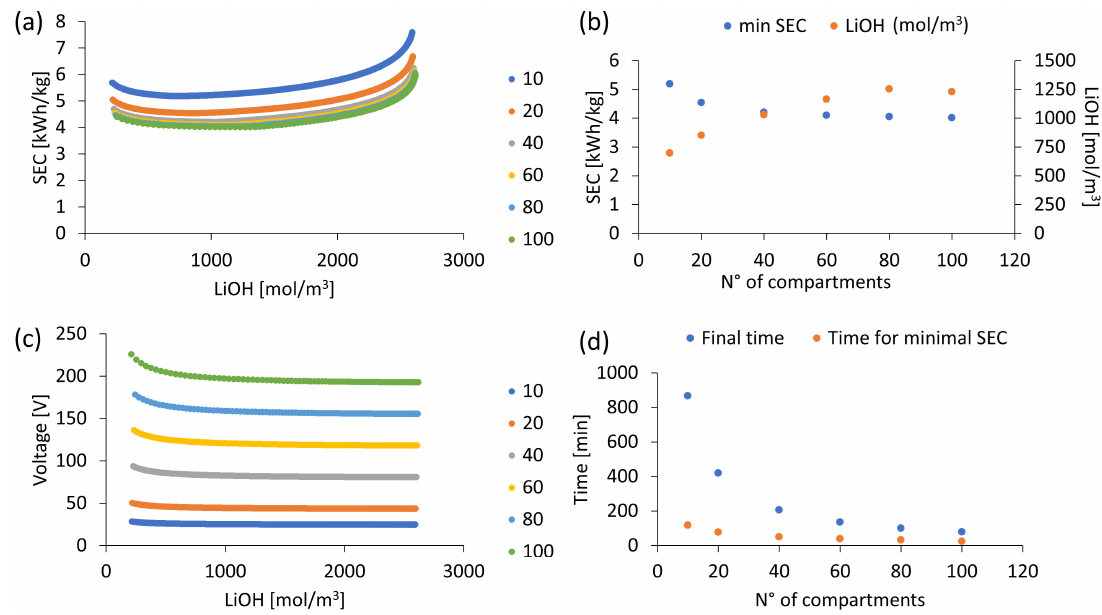
Figure 10. Number of compartments effect. Current density of 1000 A/m 2 , initial concentration 210 mol/m 3 of LiOH: ( a ) Specific electricity consumption; ( b ) Specific minimum SEC for a corresponding LiOH concentration; ( c ) Voltage variation with concentration; ( d ) Final operating time vs time for minimum SEC